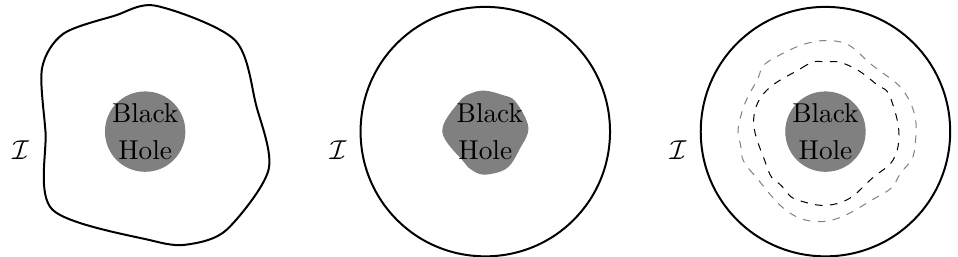
Figure 1. Schematic depiction of three ways of storing the soft hair degrees of freedom. The no hair coordinate system that uniformizes the black hole geometry is incompatible with the coordinate system that uniformizes the asymptotic geometry I . If one tries to describe the global space-time with a single coordinate patch, either the asymptotic geometry (left) or the black hole geometry (middle) is not uniformized and carries the soft hair. By using two coordinate patches, one can uniformize both the black hole and the asymptotic region. The soft hair modes are encoded in the transition function between the two